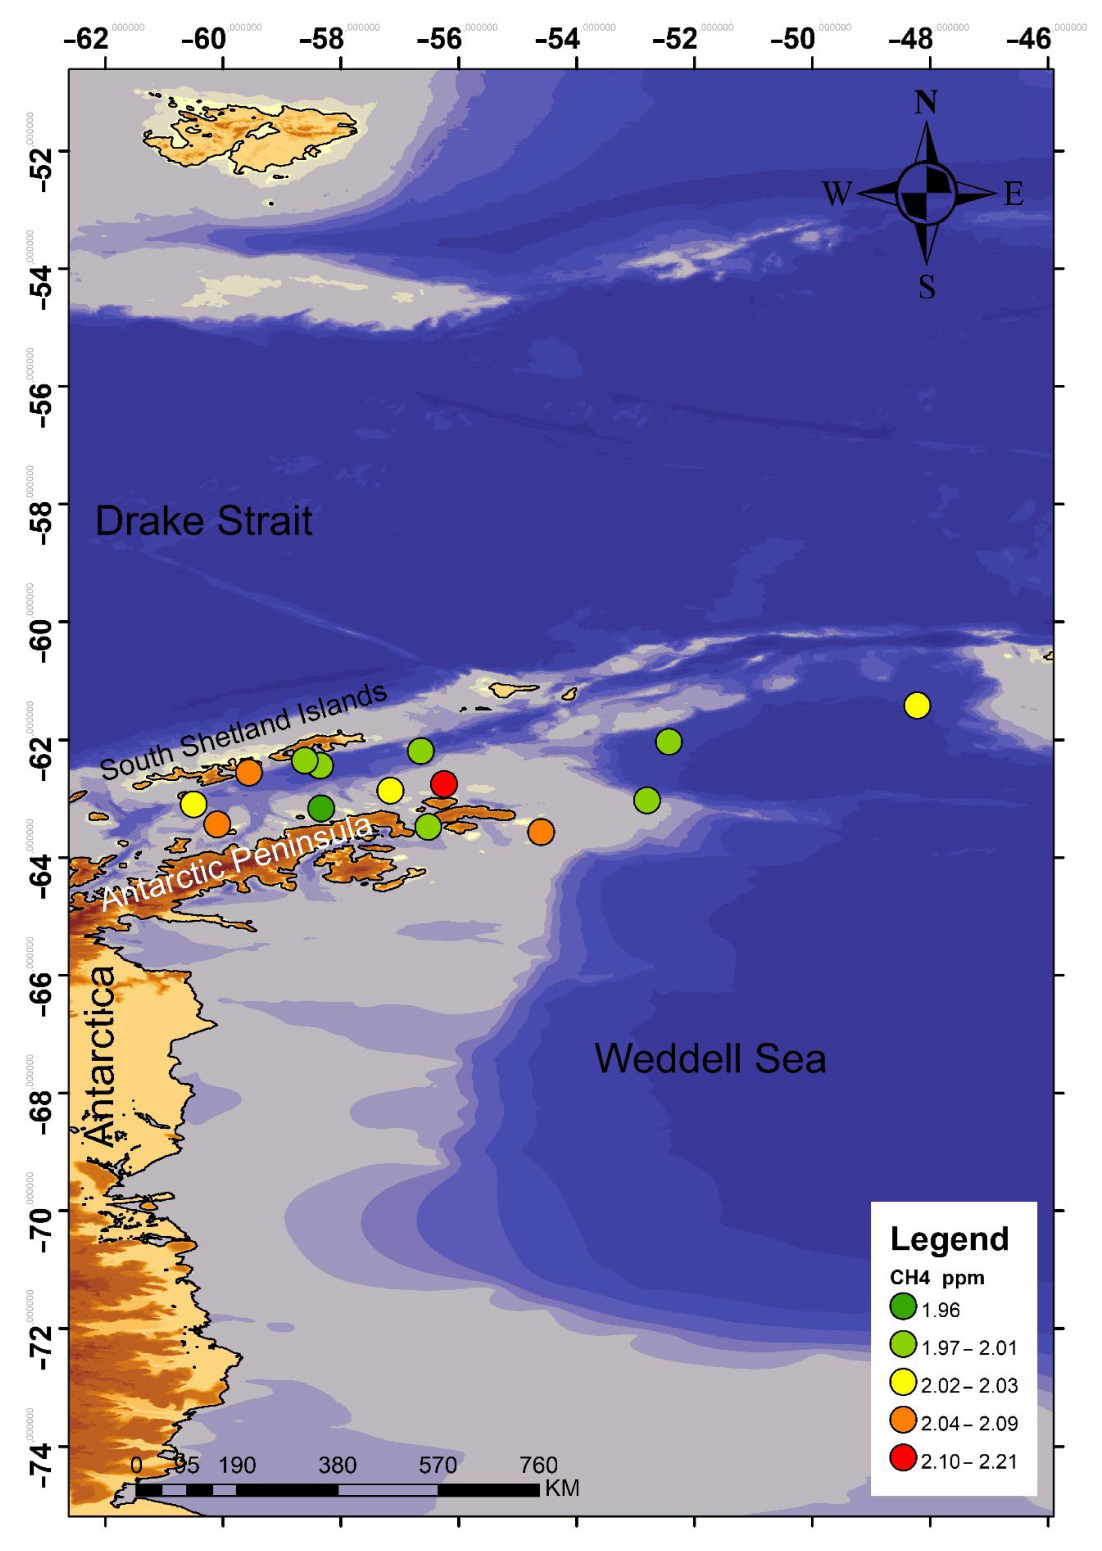
Figure 11. Methane concentration in the